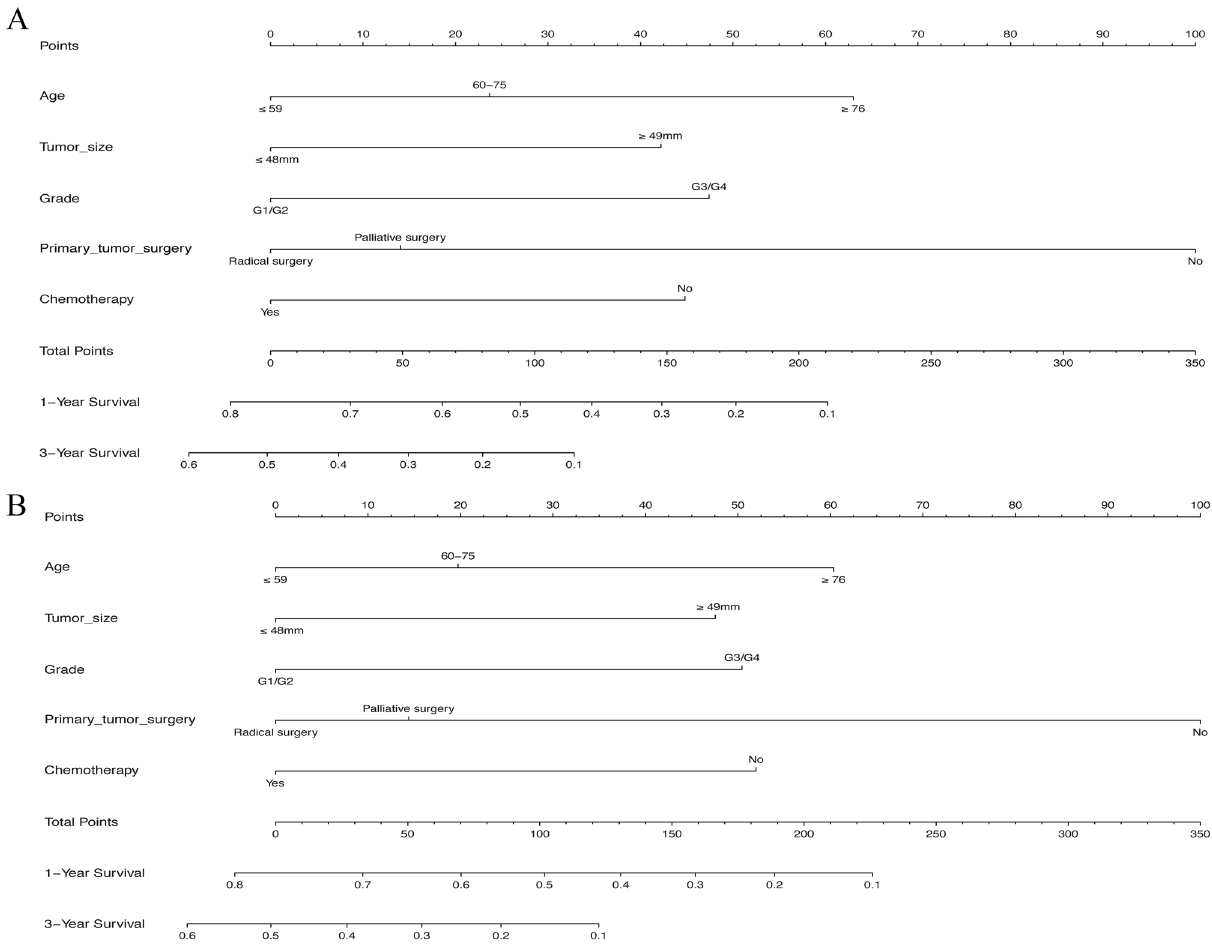
Figure 2. Nomograms to predict the probability of 1- and 3-year OS ( A ) and CSS ( B ). OS, overall survival; CSS, cancer-specific